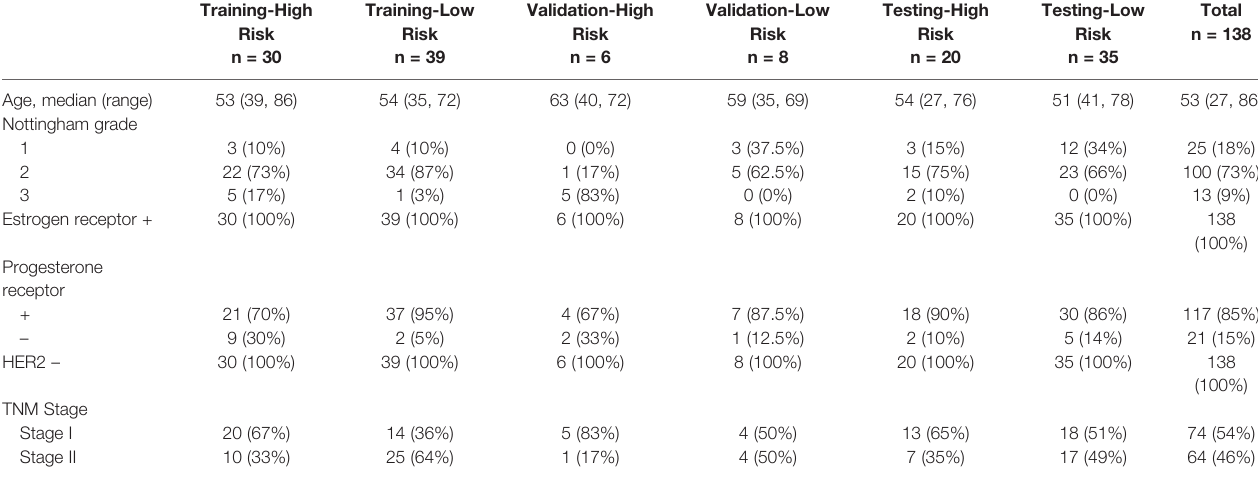
TABLE 1 | The patients ’ demographic information of the cohort dataset.